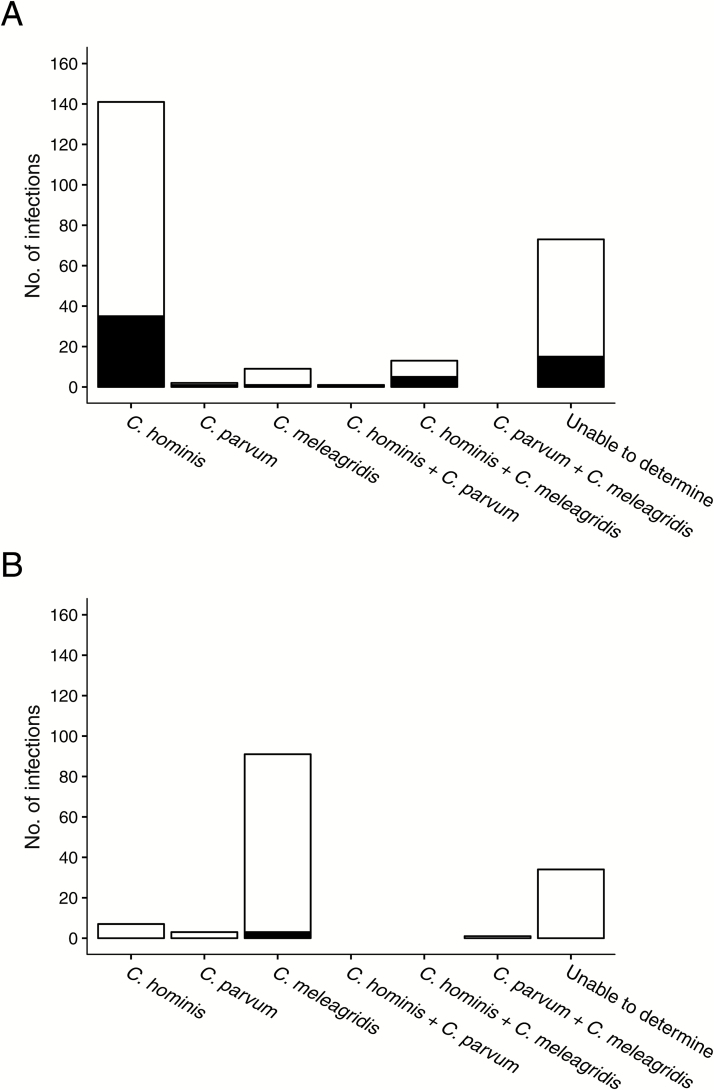

Cryptosporidium species detected and infection phenotype at urban Mirpur (A) and rural Mirzapur (B) sites. Solid bar indicates the number of diarrheal infections and open bar indicates subclinical infections.